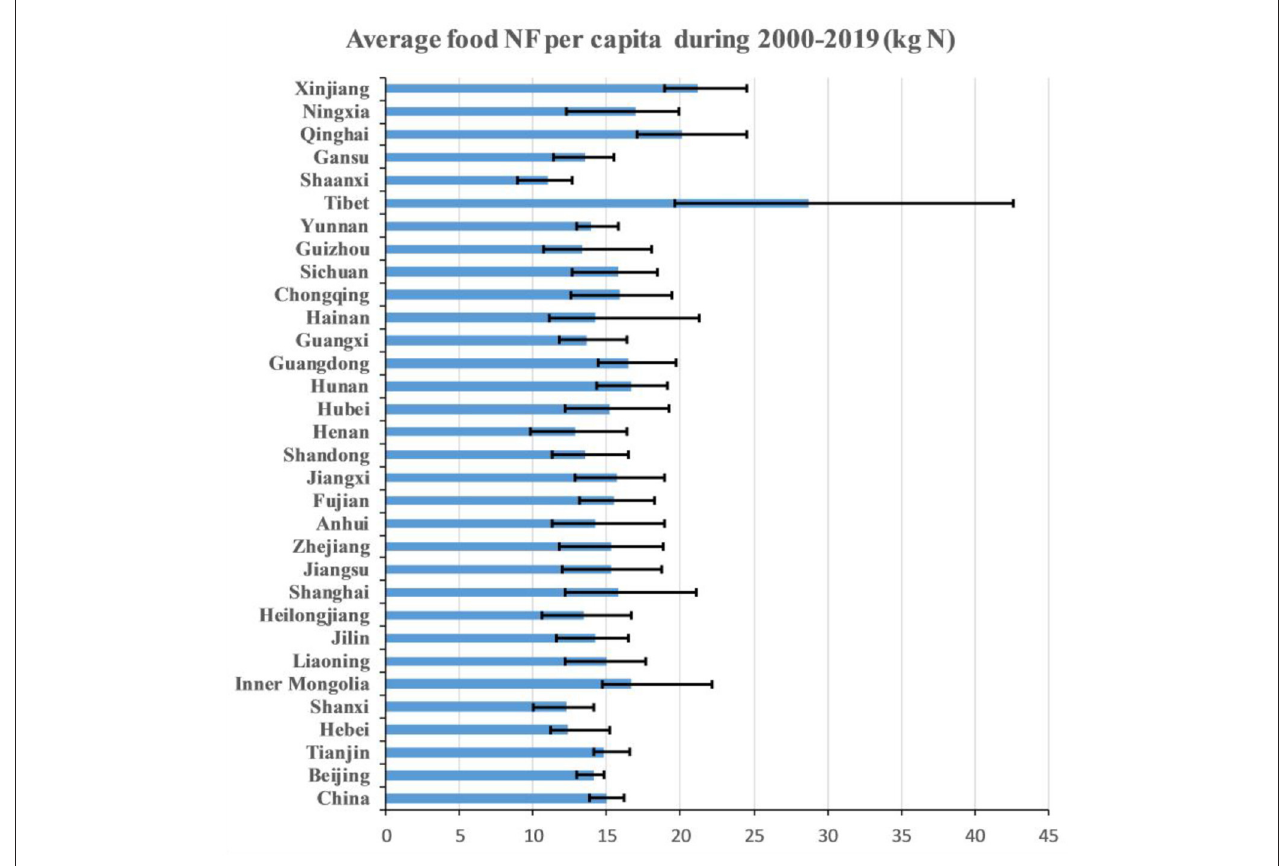
FIGURE 1 | Average rural per capita food nitrogen footprints (NFs) in nation and regions with the maximum and minimum from 2000 to